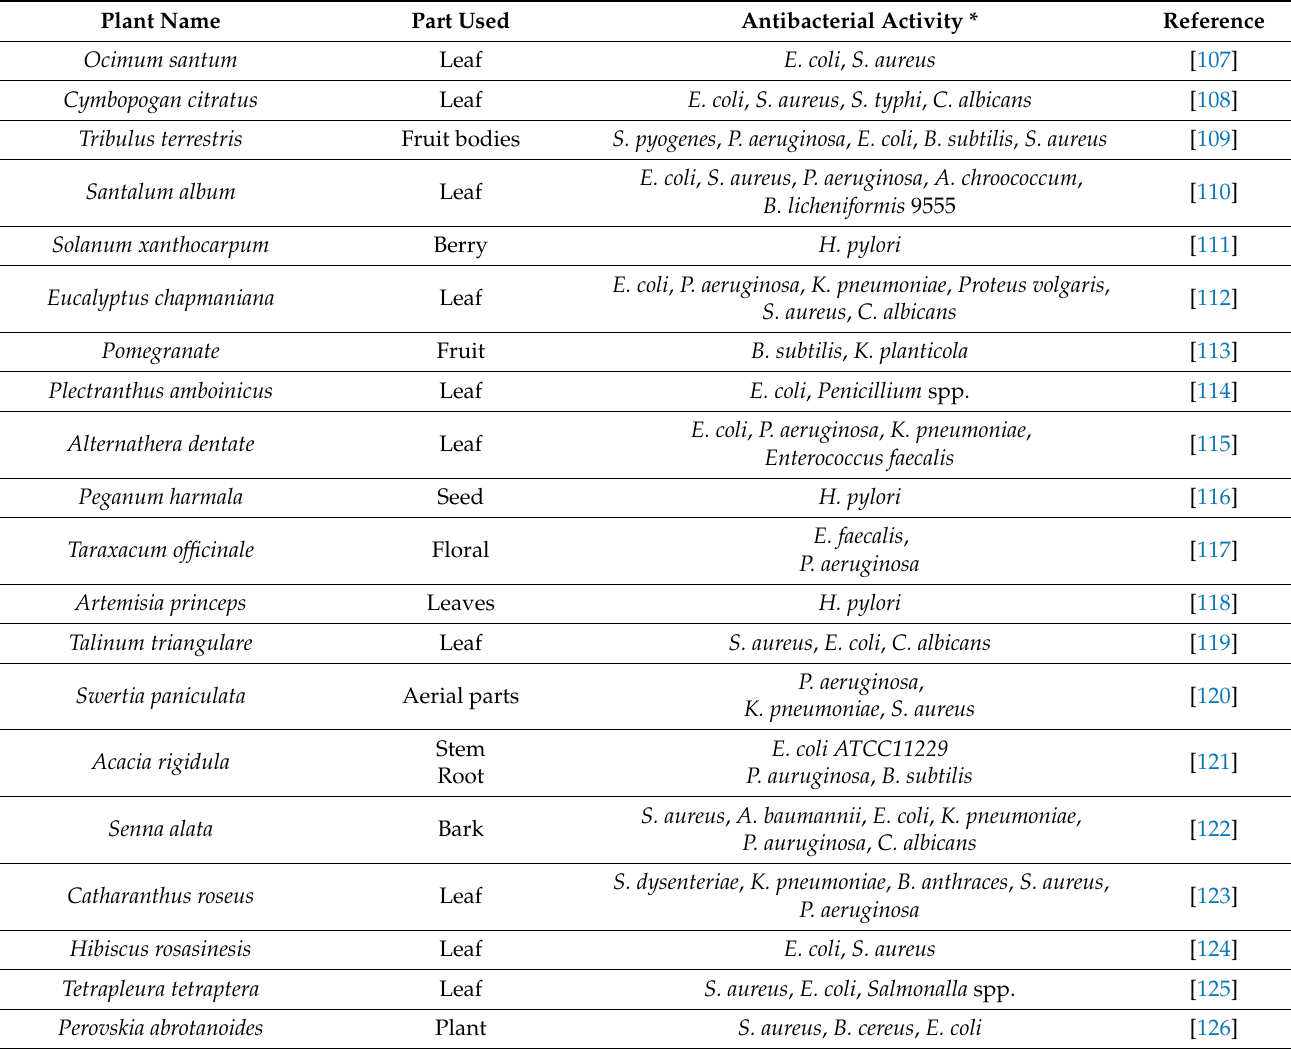
Table 2. List of natural plant–synthesized AgNPs used against